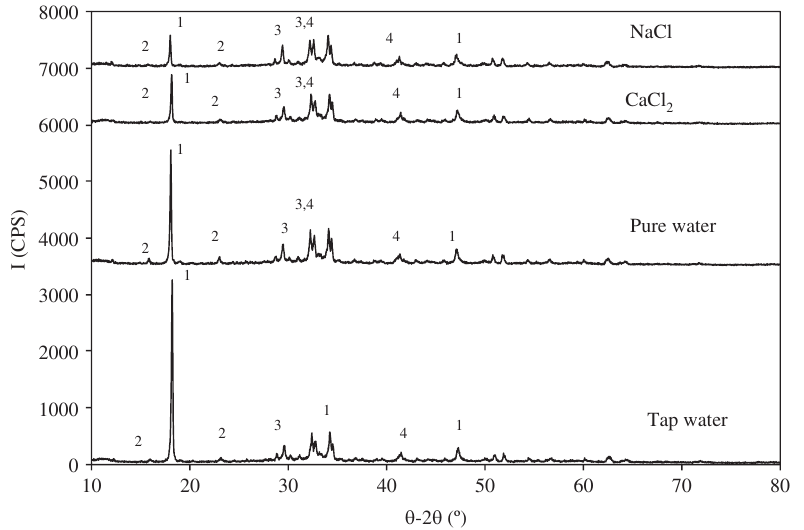
Figure 8 XRD spectrums of cement pastes prepared with different type of waters (1: portlandite; 2: ettringite; 3: alite; 4: